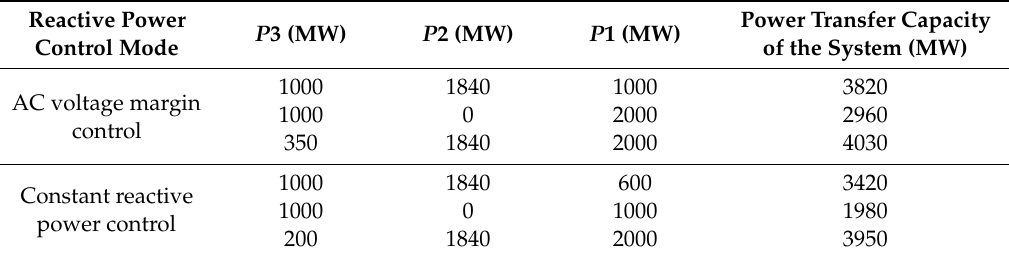
Table 1. Power transfer capacity of the system restricted by transient stability under various combinations of three power sources output.